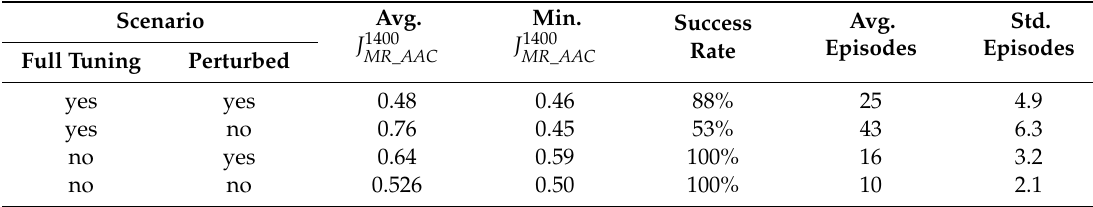
Table 1. AAC tuning statistics over maximum 50 episodes per